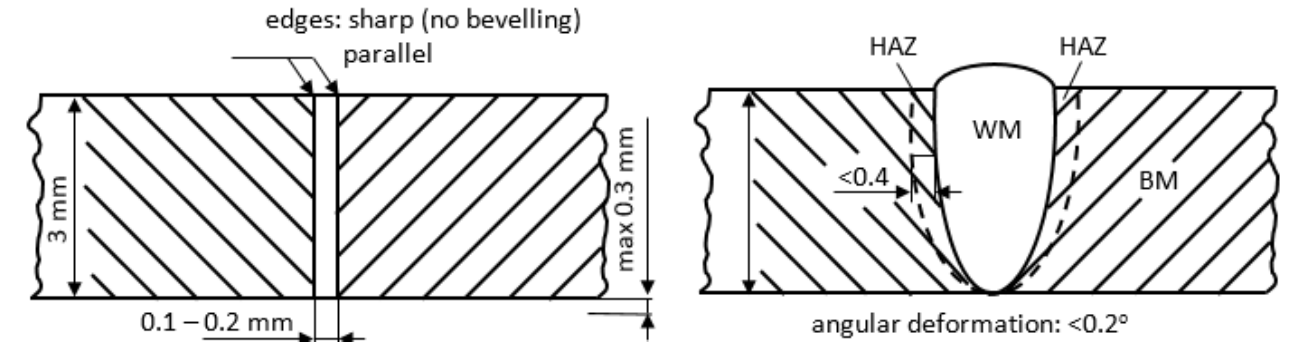
Figure 1. The joint design requirements. Table 1. The LBW parameters used for welding. Table 2. The chemical composition of 17-4 PH stainless steel used for welding. Element